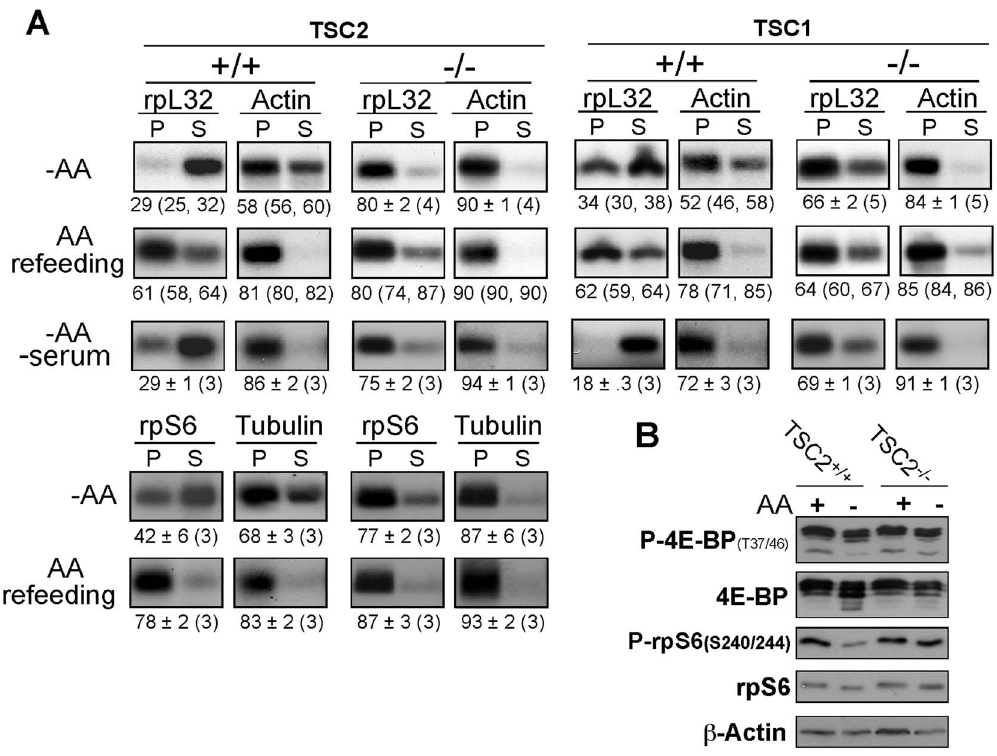
Figure 1. TSC2 or TSC1 deficiency rescues TOP mRNAs from translational repression in amino acid-starved cells. (A) TSC2 + / + and TSC2 2 / 2 as well as TSC1 + / + and TSC1 2 / 2 MEFs, were amino acid-starved for 16 h ( 2 AA), amino acid-starved and then refed for 2 h, or amino acid staved during the last 16 h of 48 h serum starvation ( 2 AA 2 serum). Subsequently cells were harvested and cytoplasmic extracts were prepared. These extracts were centrifuged through sucrose gradients and divided into polysomal (P) and subpolysomal (S) fractions. RNA from equivalent aliquots of these fractions was analyzed by Northern-blot hybridization with cDNAs for rpL32 mRNA (a TOP mRNA) and actin mRNA (a non TOP mRNA) (in the case of TSC2 also with cDNAs corresponding to rpS6 and tubulin). The radioactive signals were quantified, and the relative translational efficiency (% of the P signal relative to the P + S signals) of each mRNA is numerically presented beneath the autoradiograms as percentage of the mRNA engaged in polysomes. These figures are expressed as an average 6 SEM of the number of determinations in parenthesis, or the average with the individual values in parenthesis, if only two determinations are presented. (B) TSC2 + / + , TSC2 2 / 2 MEFs were untreated or amino acid-starved for 16 h and then harvested. The cytoplasmic proteins were subjected to Western blot analysis using the indicated